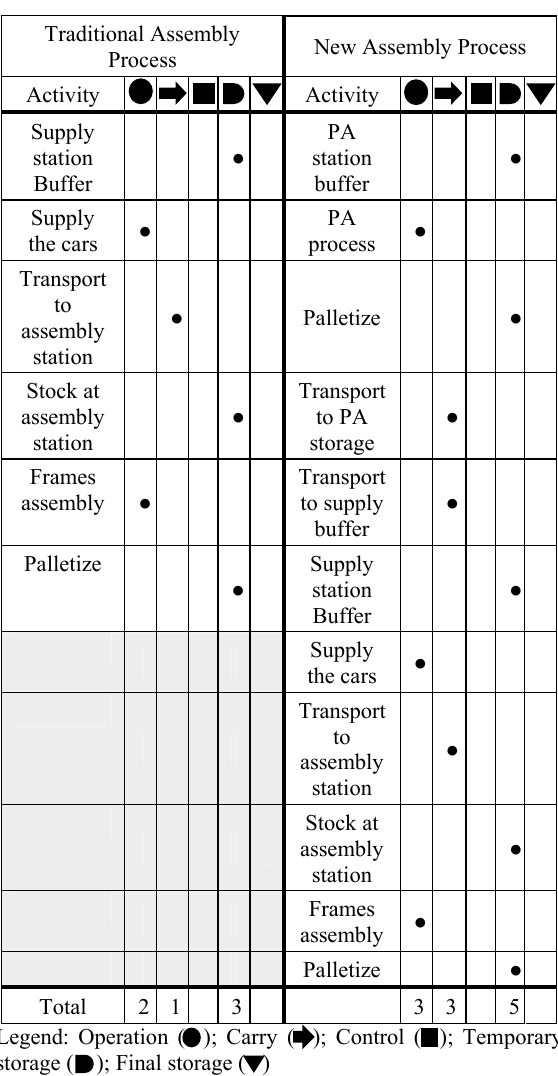
Weight range of manipulated parts (kg)